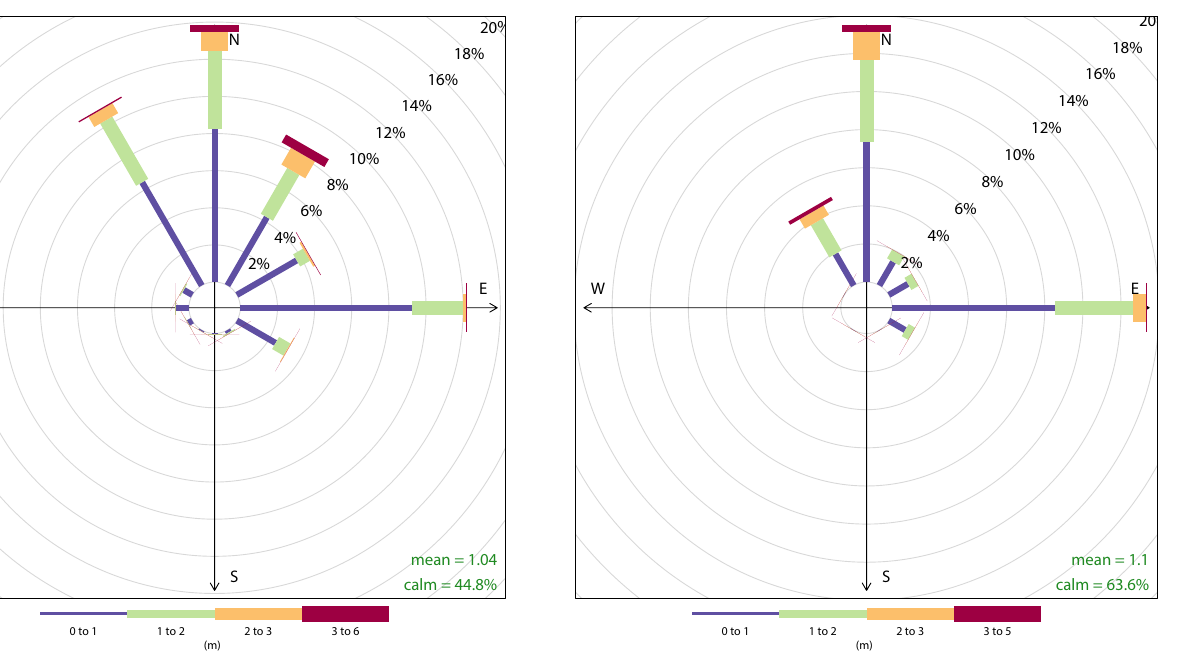
Figure 7. Simulated wave climate over 10 months of hourly time series at